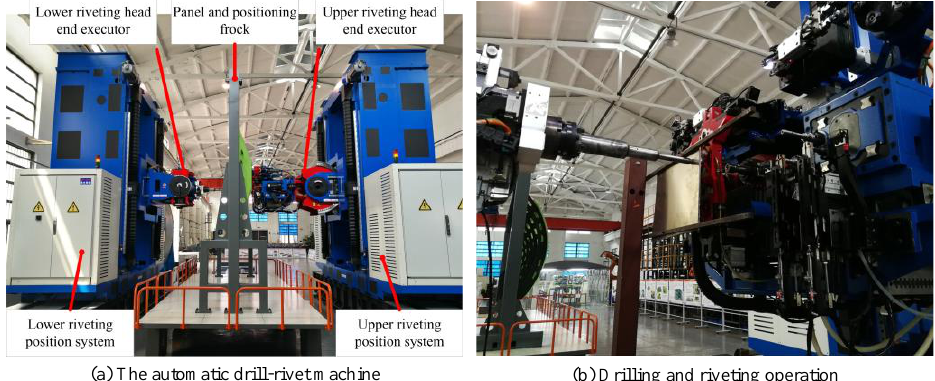
Figure 14. The automatic drilling and riveting machine and its experimental process. ( a ) The automatic drill-rivet machine; ( b ) Drilling and riveting operation.